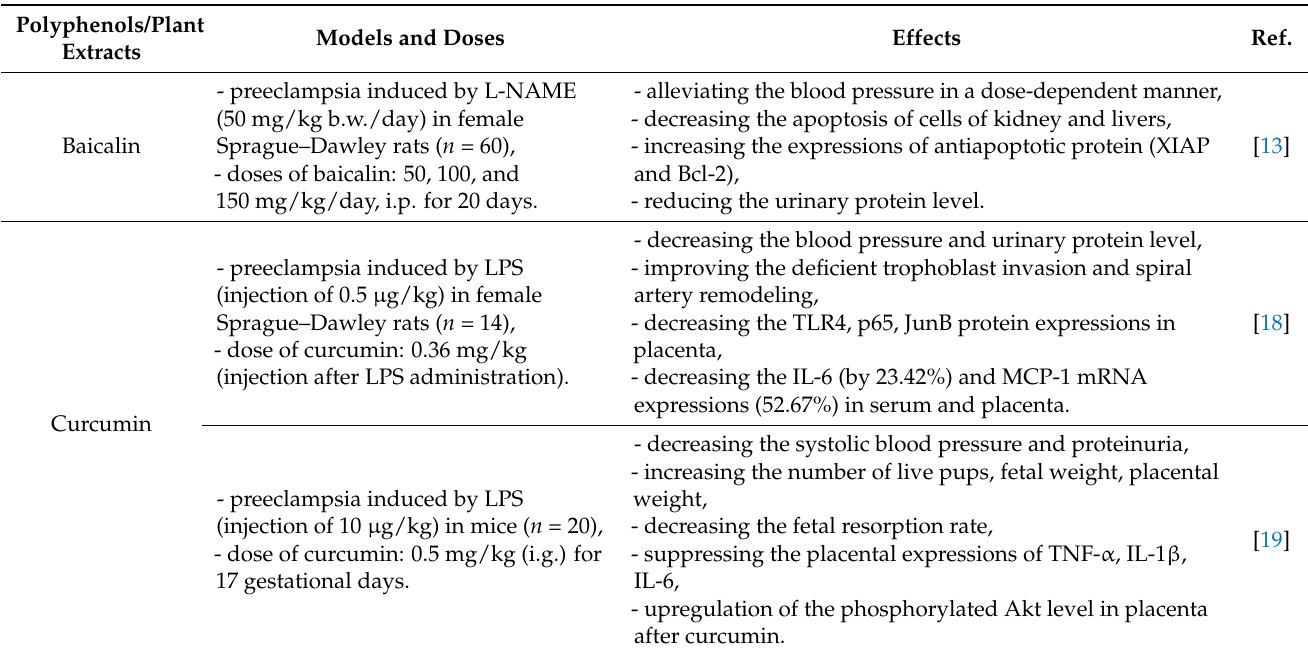
Table 1. Summary of studies on pharmacological effects of plant-derived polyphenols and plant extracts in animal models of preeclampsia.